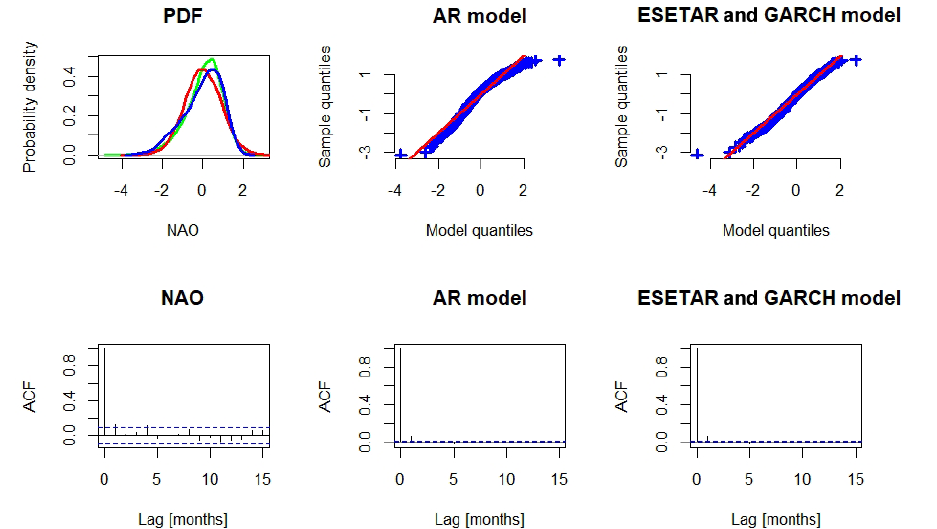
Figure 12. Simulations of monthly means of the NAO. The plots are identical to Fig. 11, but with weekly means replaced by monthly means.